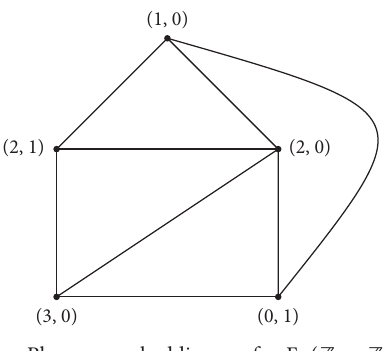
1: Planar embedding